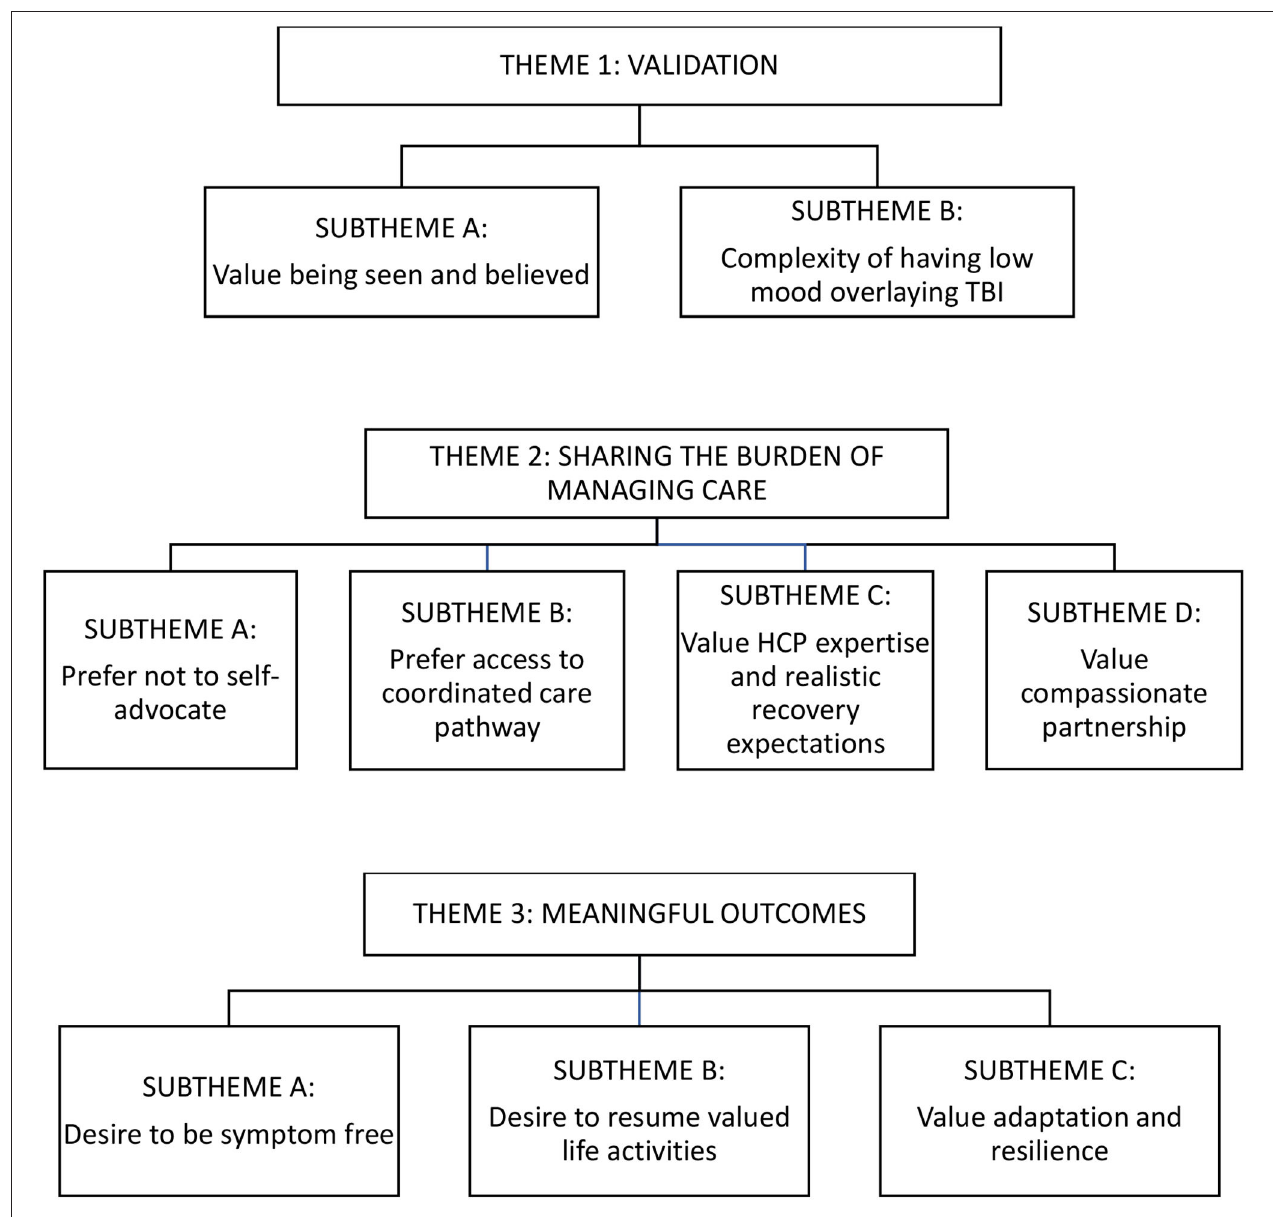
FIGURE 1 | Thematic